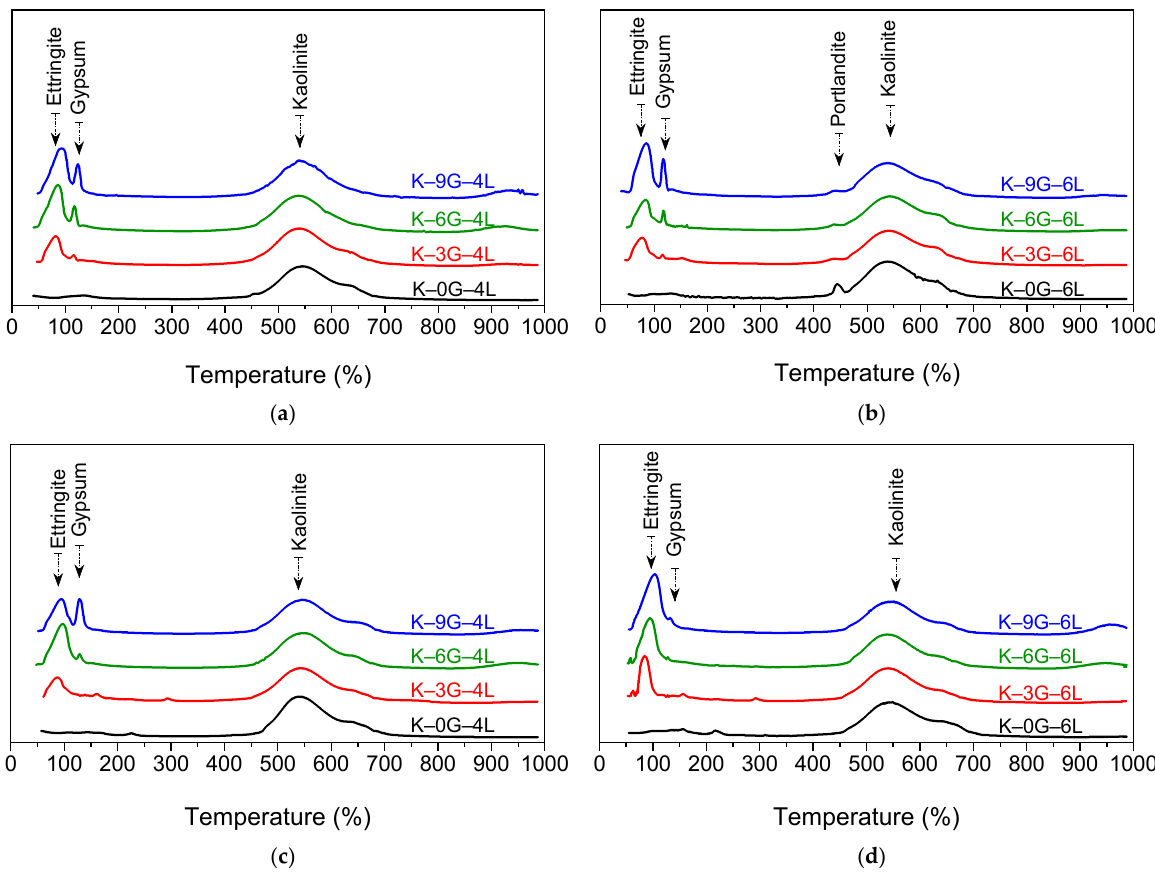
Figure 7. The DTG curves of kaolin specimens made with different gypsum contents (0, 3, 6, and 9 wt%) and stabilised with two lime levels (4 and 6 wt%): ( a ) kaolin specimens stabilised with 4 wt% of lime after 7 days of moist curing, ( b ) kaolin specimens stabilised with 6 wt% of lime after 7 days of moist curing, ( c ) kaolin specimens stabilised with 4 wt% of lime after 200 days of soaking, and ( d ) kaolin specimens stabilised with 6 wt% of lime after 200 days of soaking.